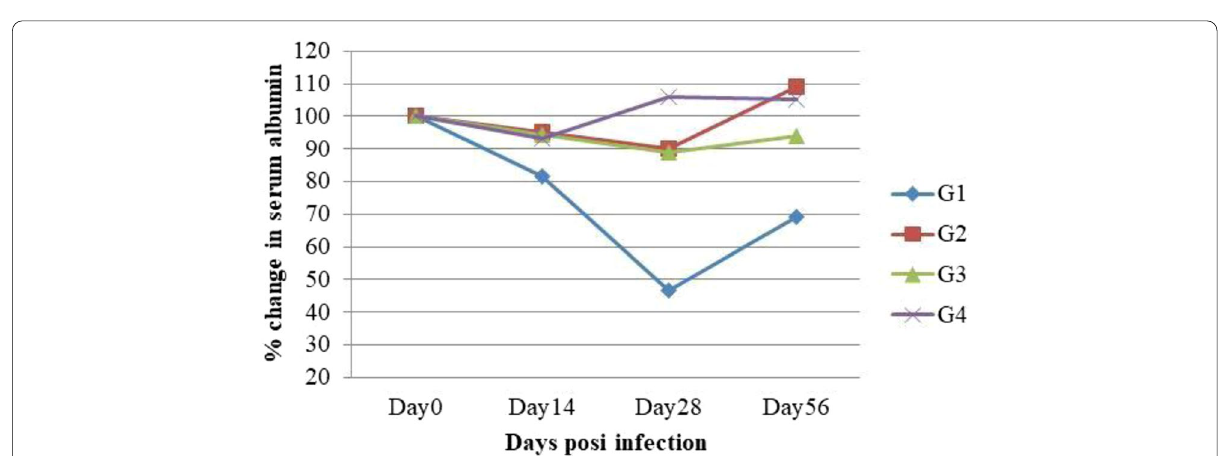
Fig. 6 Percentage changes in mean serum Albumin concentration in infected (G1, G3) and non-infected (G2, G4) goat and sheep